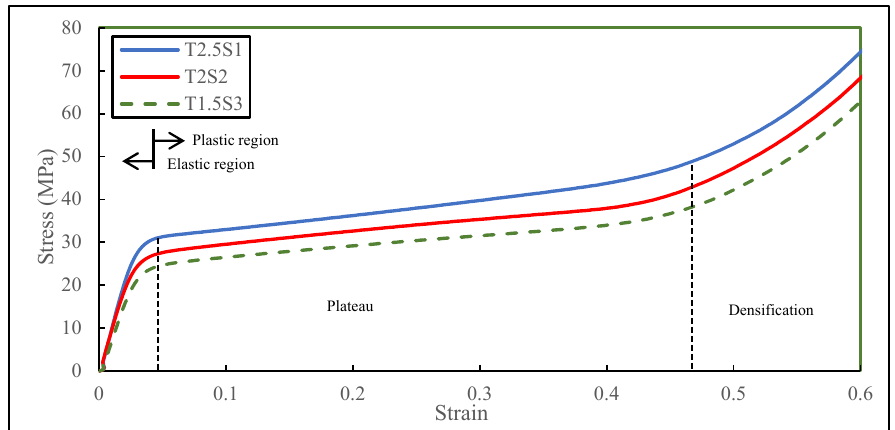
Figure 6. Stress–strain responses of the three biomimetic porous sandwich structure specimens. Table 6. Variation in compressive responses.